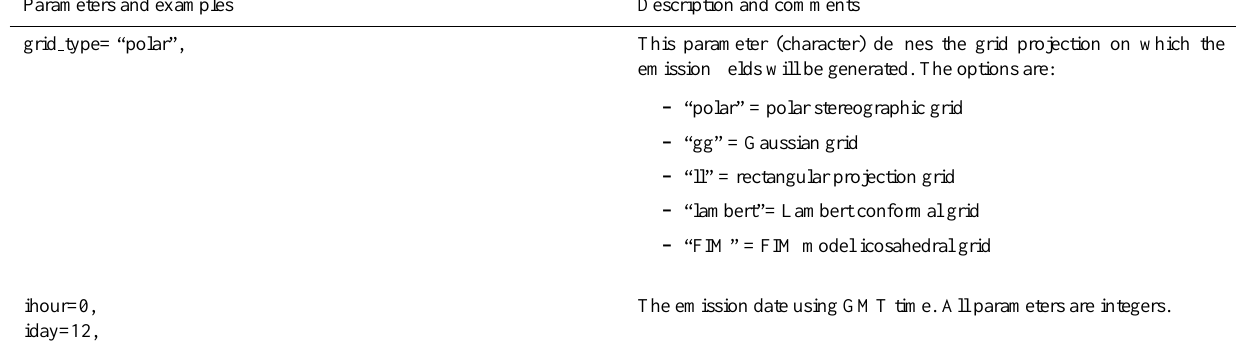
Table A1. Parameters of “prep-chem-src.inp” namelist file, version